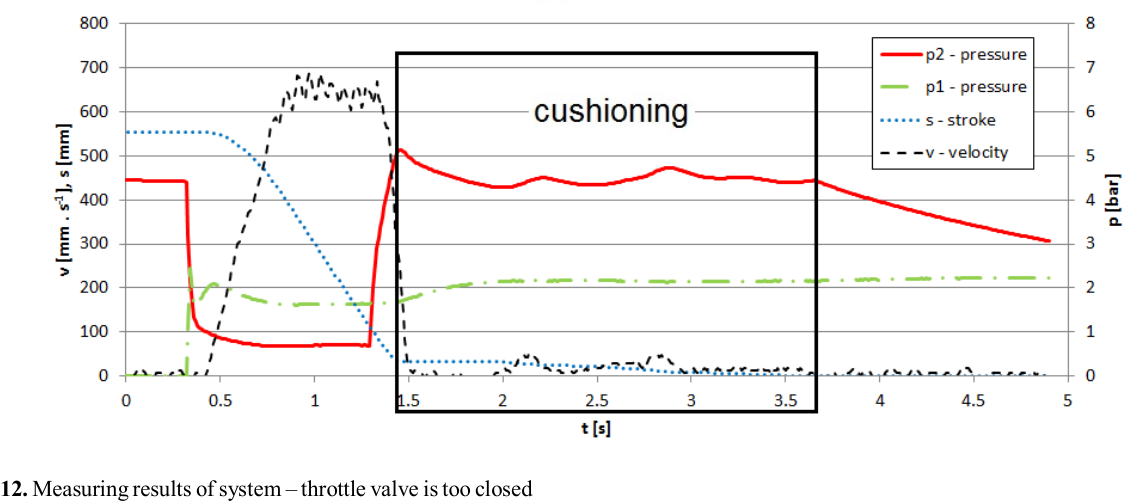
Fig. 12. Measuring results of system – throttle valve is too closed